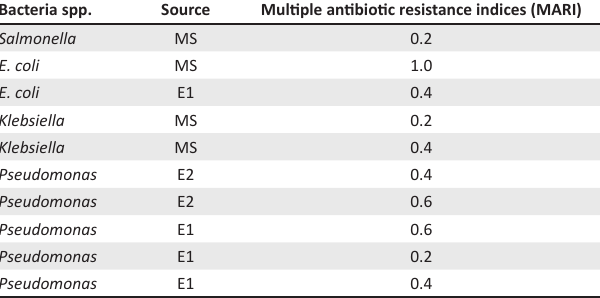
FIGURE 4: Antibiotic sensitivity and resistance pattern for Pseudomonas TABLE 2: Multiple antibiotic resistance indices of isolates to selected antibiotics. Bacteria spp.